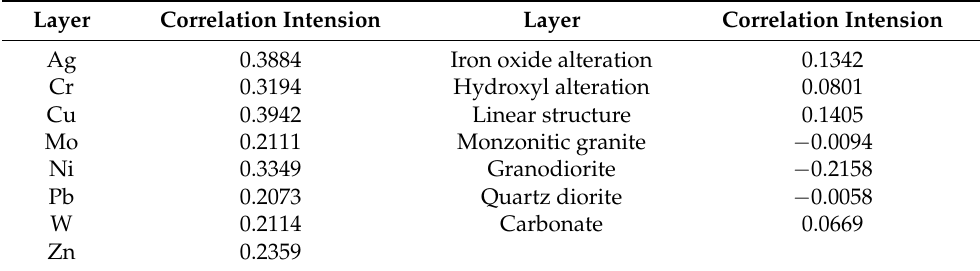
Table 2. Youden index for metallogenic evidence